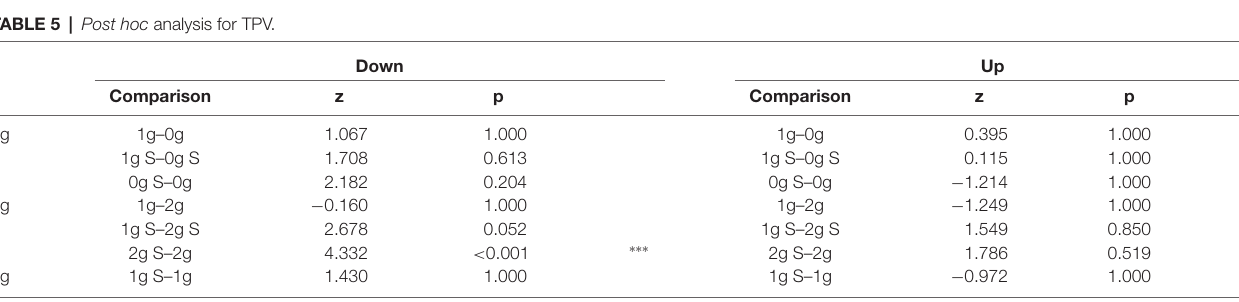
TABLE 5 | Post hoc analysis for TPV. Down